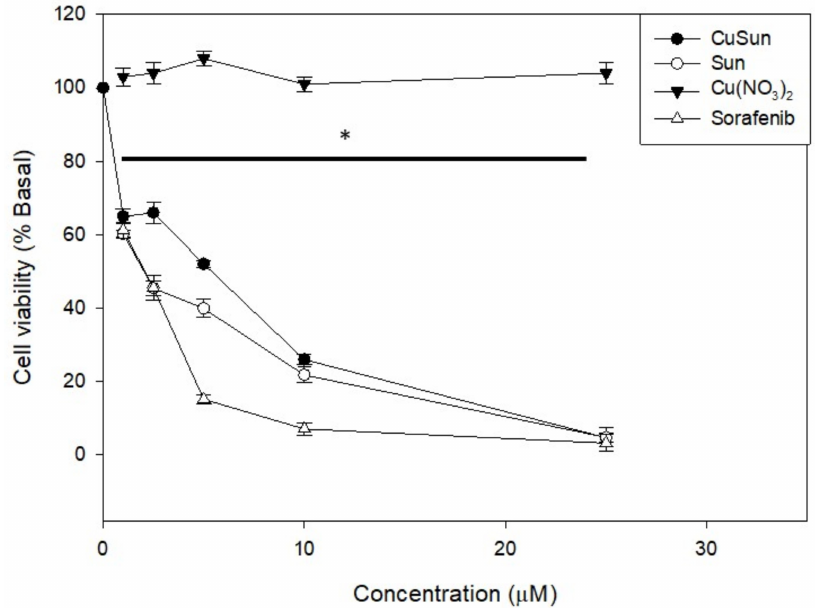
Figure 5. Cell viability of CuSun, Sun, Cu(NO 3 ) 2 and Sorafenib on HepG2 cancer cells. HepG2 cells were incubated in Dulbecco’s modified Eagle’s medium (DMEM) alone (control) or with different concentrations (1 to 25 µ M) of Cu-SUT, SUT, Cu +2 and Sorafenib. The results are expressed as the percentage of the basal level and represent the mean ± the standard error of the mean (SEM) ( n = 18). * p < 0.01 differences between control and